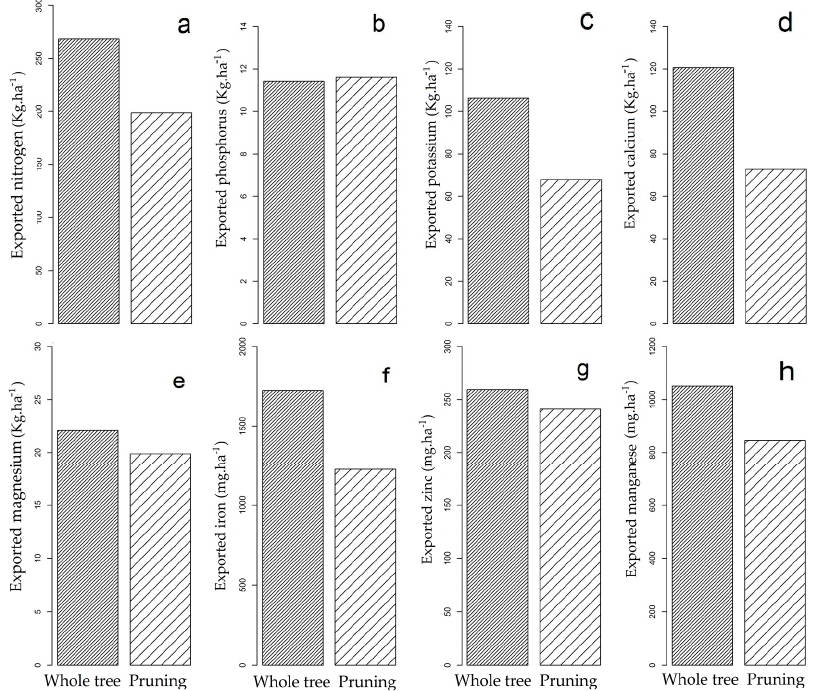
Figure A7. Sum of nutrients exported by the sequential management of whole trees and pruning 100% of the canopy in two commercial plantations in Maués, AM. ( a ) Nitrogen; ( b ) Phosphorus; ( c ) Potassium; ( d ) Calcium; ( e ) Magnesium; ( f ) Fe; ( g ) Zinc; ( h ) Manganese.